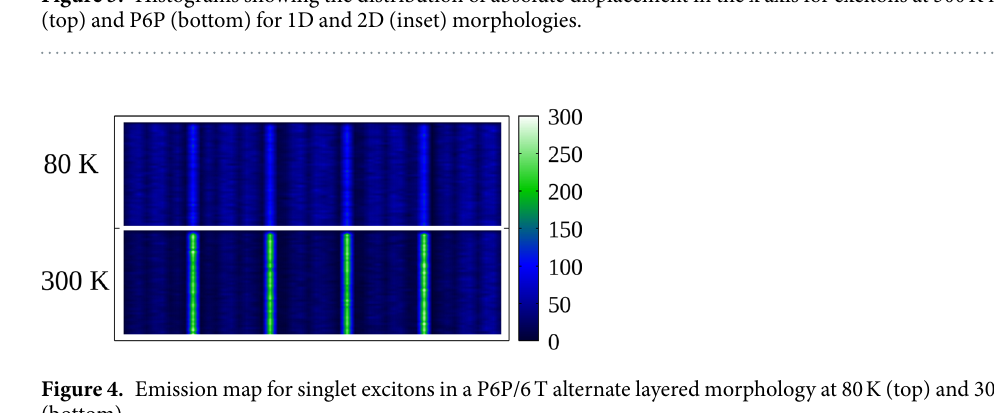
Figure 3. Histograms showing the distribution of absolute displacement in the x axis for excitons at 300 K in 6 T (top) and P6P (bottom) for 1D and 2D (inset) morphologies.